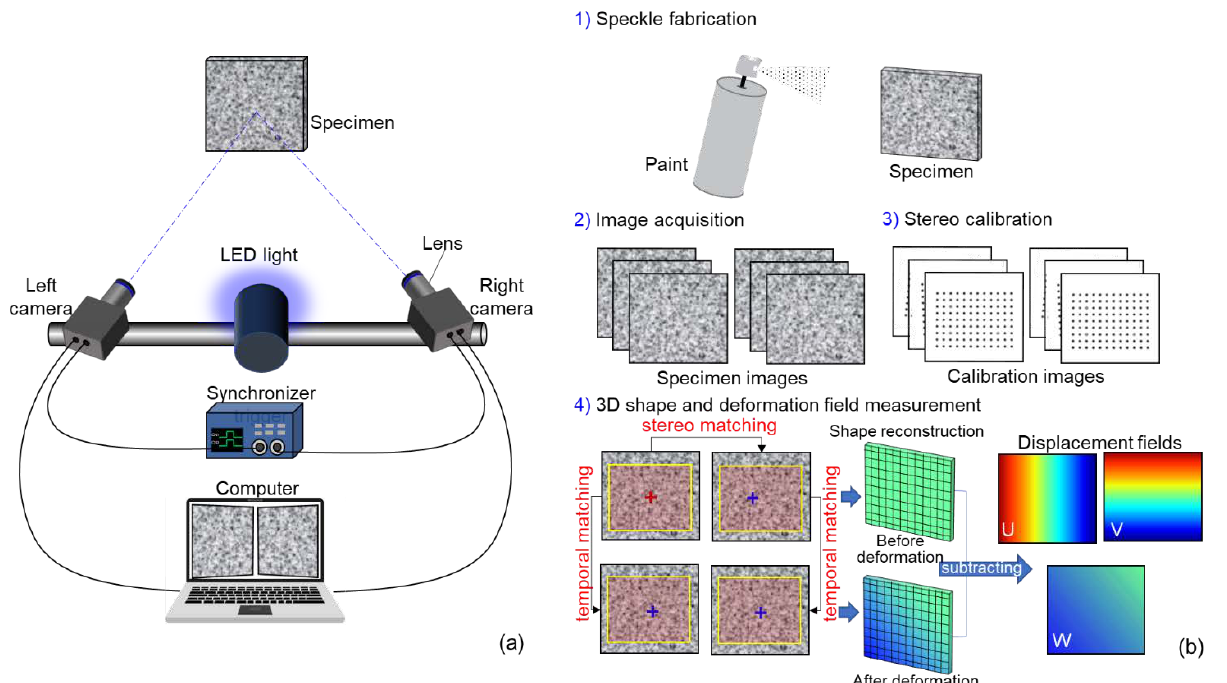
Figure 1. ( a ) System configuration of stereo-DIC and ( b ) implementation procedures of stereo-DIC measurement. DIC